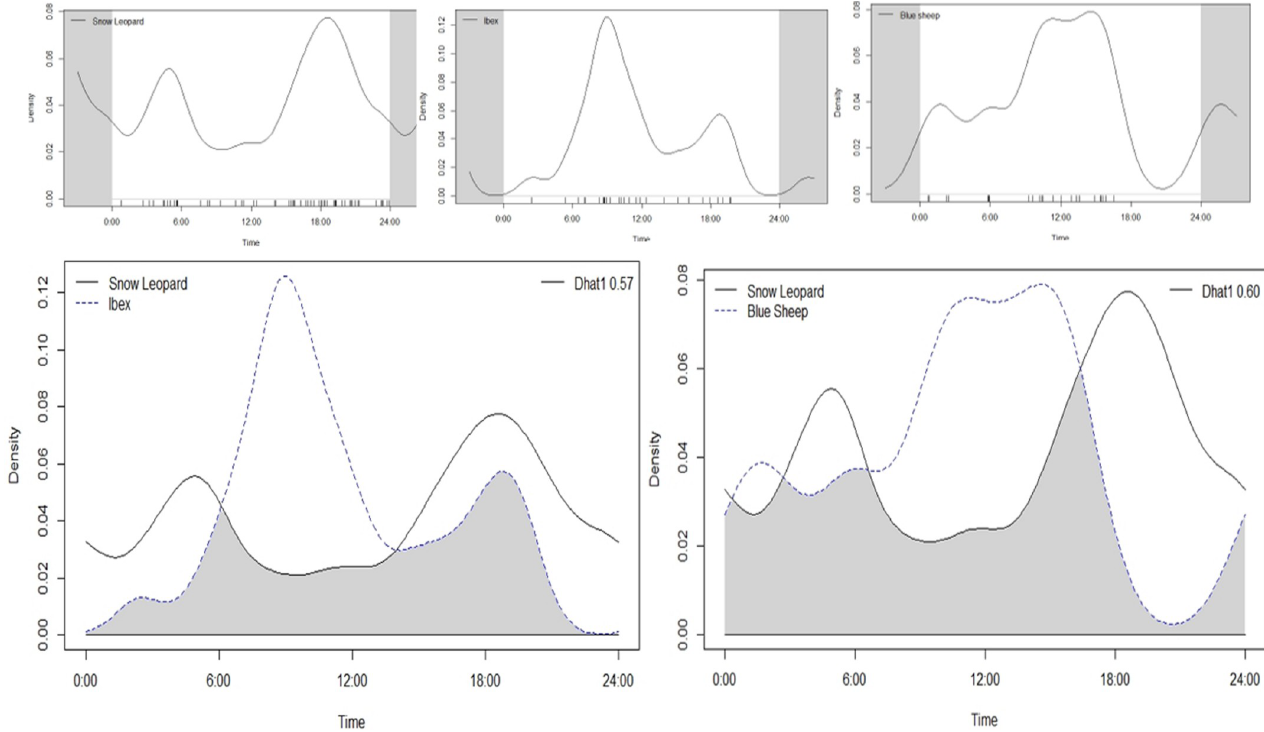
Fig 5. Temporal activity pattern of Snow leopard, Ibex and Blue sheep (top row) and overlapping activity pattern of predator-prey (bottom row) in Spiti Valley.